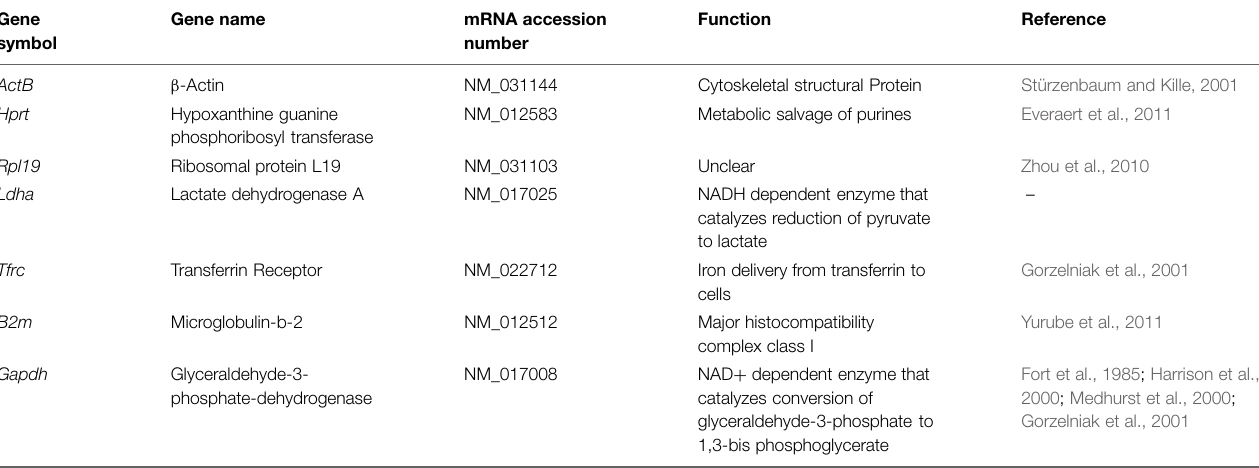
TABLE 2 | Panel of seven candidate housekeeping genes selected for expression